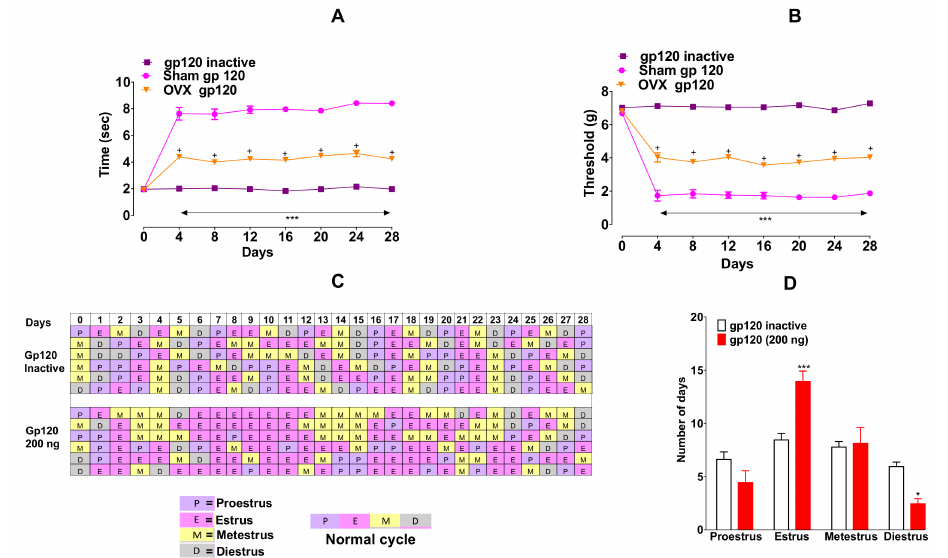
Figure 2. Ovariectomized (OVX) mice show less pain sensitivity compared to sham. Gp120 (200 ng/10 µ L, (i.t) induced cold hypersensitivity (2A) and mechanical allodynia and (2B) in both sham and OVX mice. OVX mice showed lower pain sensitivity in mechanical allodynia ( A ) and thermal hypersensitivity ( B ) compared to sham. *** p < 0.0001, + p < 0.05 (two-way ANOVA, multiple comparisons, Bonferroni post hoc). Data are expressed as mean ± S.E.M. ( n = six per group). Gp120 altered the estrous cycle ( C ). Time spent in estrus was prolonged ( D , p < 0.001) and diestrus was reduced ( D , p < 0.01) compared to heat-inactivated gp120. *** p < 0.001, * p < 0.05 vs. gp120 inactive group (two-way ANOVA, multiple comparisons, Bonferroni post hoc). Data are expressed as mean ± S.E.M. ( n = 6 per